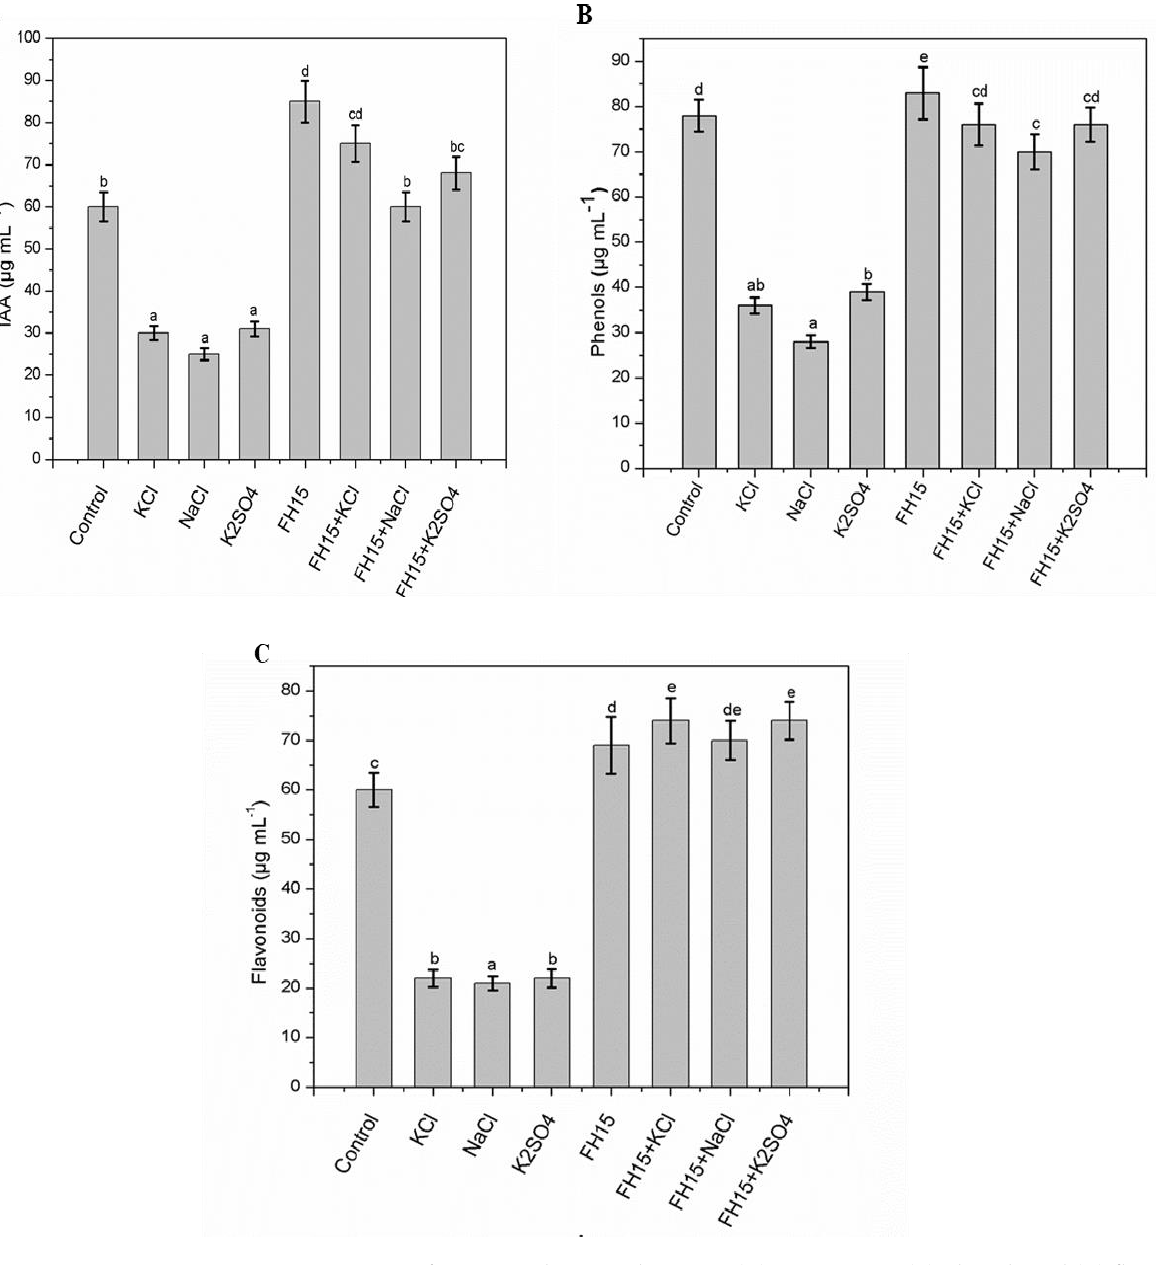
Figure 6. Impact of various salts on endogenous ( A ) IAA content ( B ) phenols and ( C ) flavonoids contents of maize with or without endophytic fungal strain C. membranifaciens FH15. The bars represent mean with ± SE and the different letters on the bars represent significance at p = 0.05.